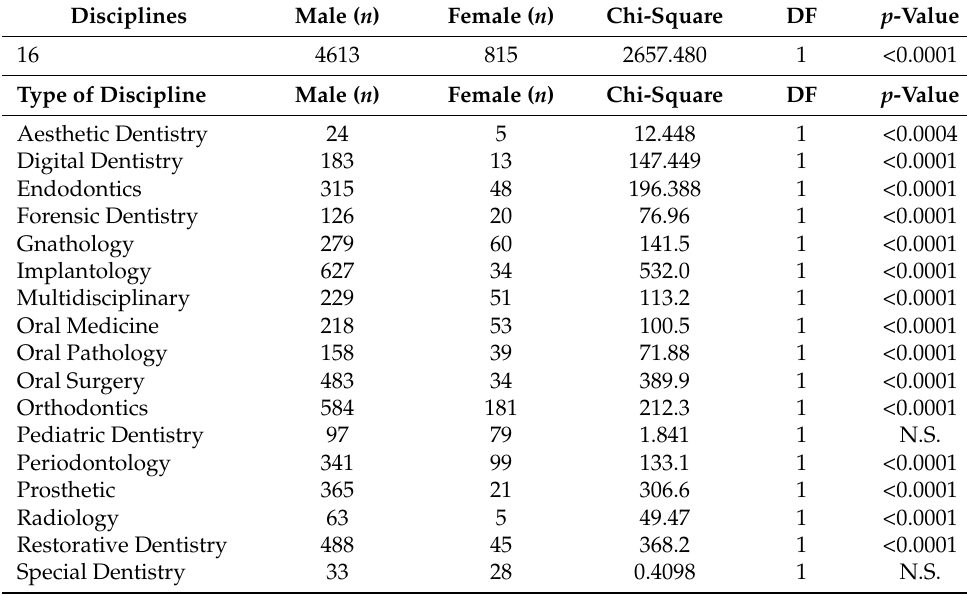
Table 7. Numbers of male and female dental speakers at the cultural events registered in the framework of the CME program from 1 January 2019 to 1 January 2022. DF = degree of freedom. N.S. = not significant.